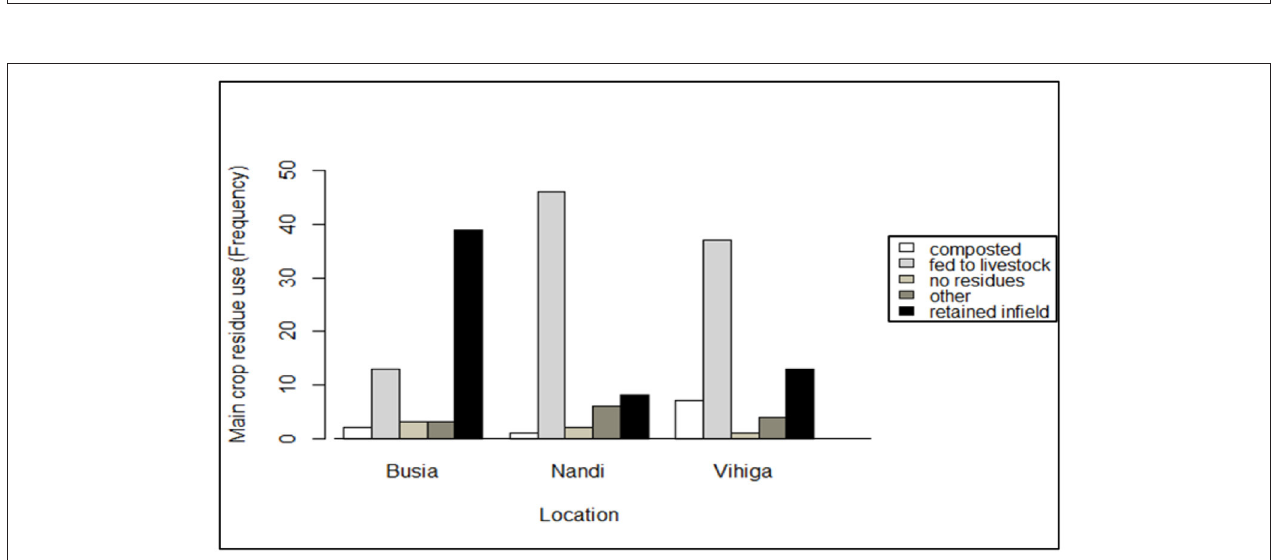
FIGURE 3 | Frequency of the farmers in Busia, Nandi, and Vihiga counties in western Kenya who allocate crop residues produced from their main plot for to a variety of different uses.